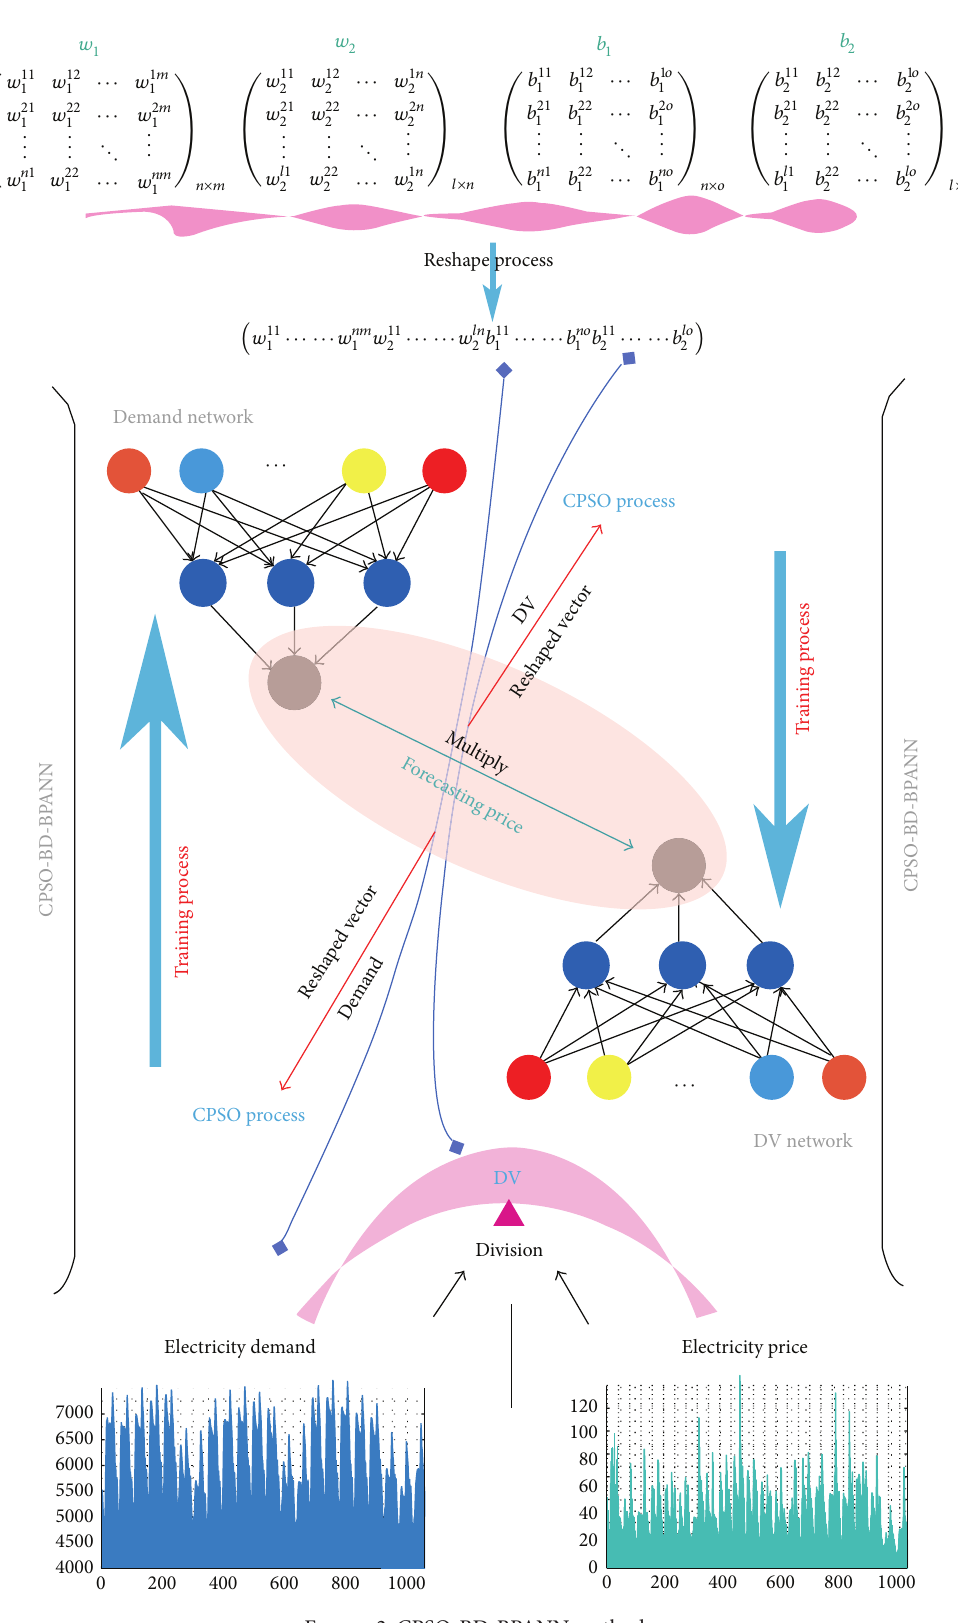
Figure 2: CPSO-BD-BPANN